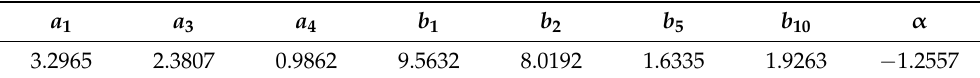
Table 7. Anisotropic and tension–compression asymmetry parameters of the J 0 SMA at − 10 ◦ C.